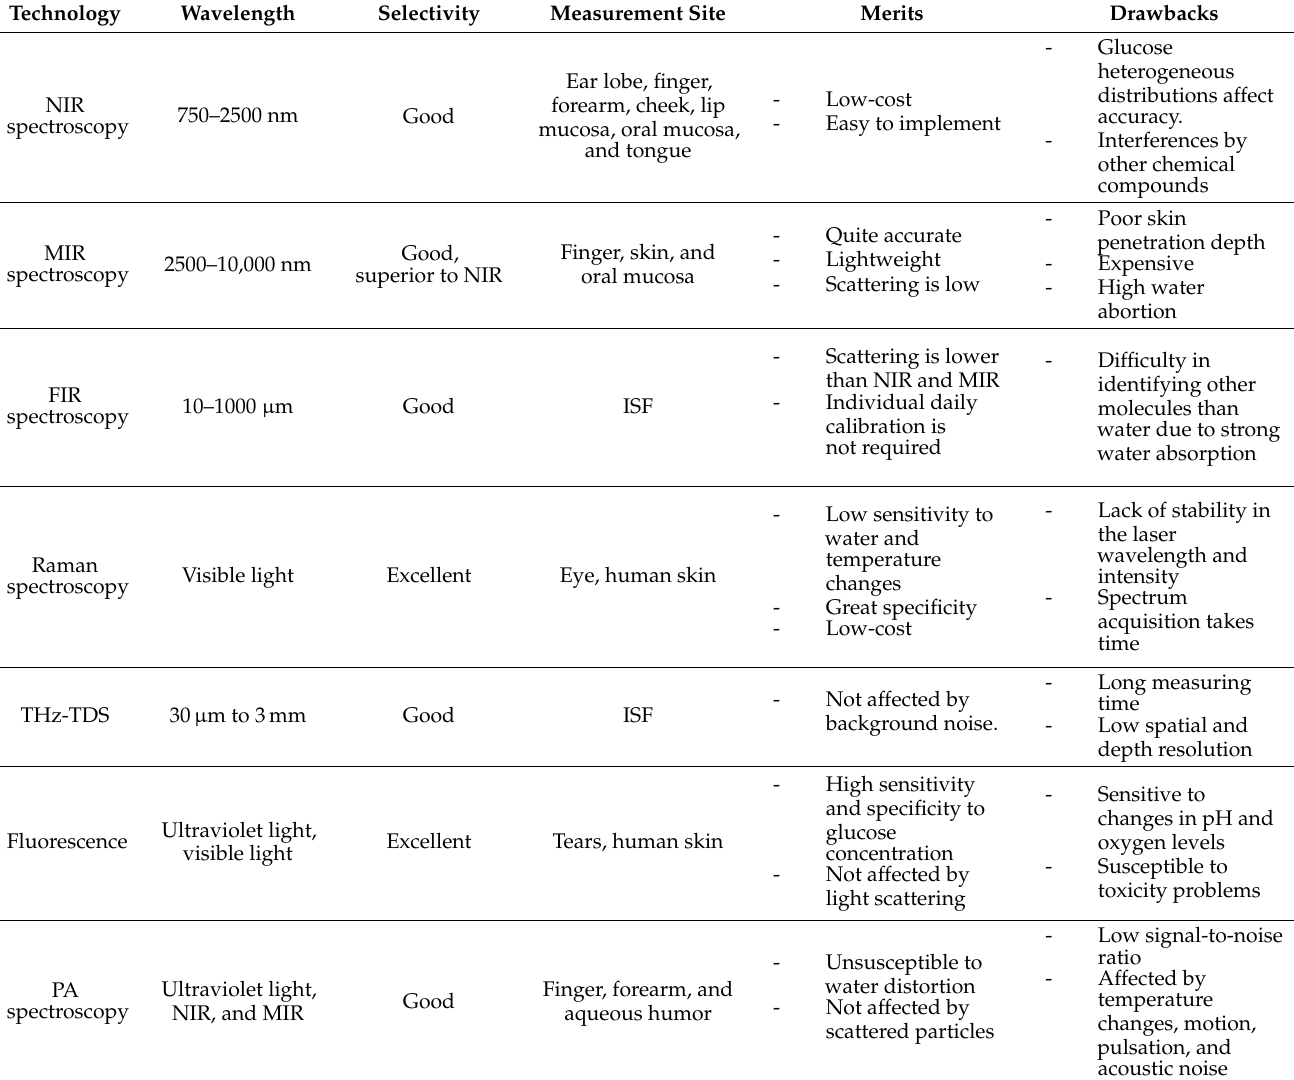
Table 2. Comparison of various non-invasive optical glucose sensing techniques